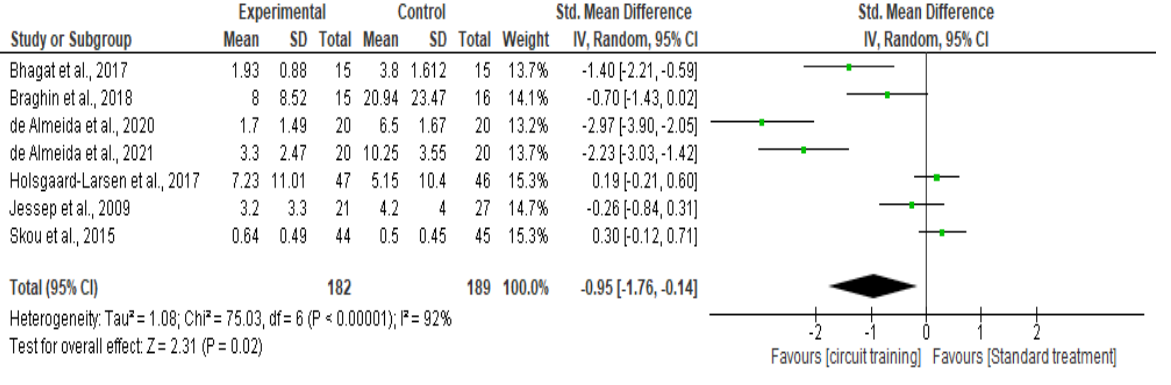
Figure 4. Forest plot analysis of the effect of CT on pain level outcome [33,38–43]. Table 2. Summary of finding using GRADE quality